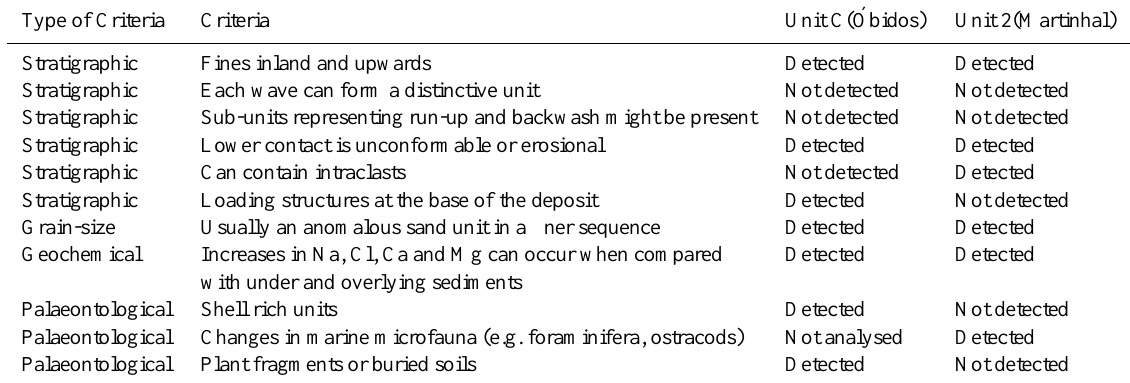
Table 3. Comparison of unit C ( ´Obidos) and unit 2 (Martinhal) sedimentological criteria associated with tsunamigenic deposition (based in literature; see references in the